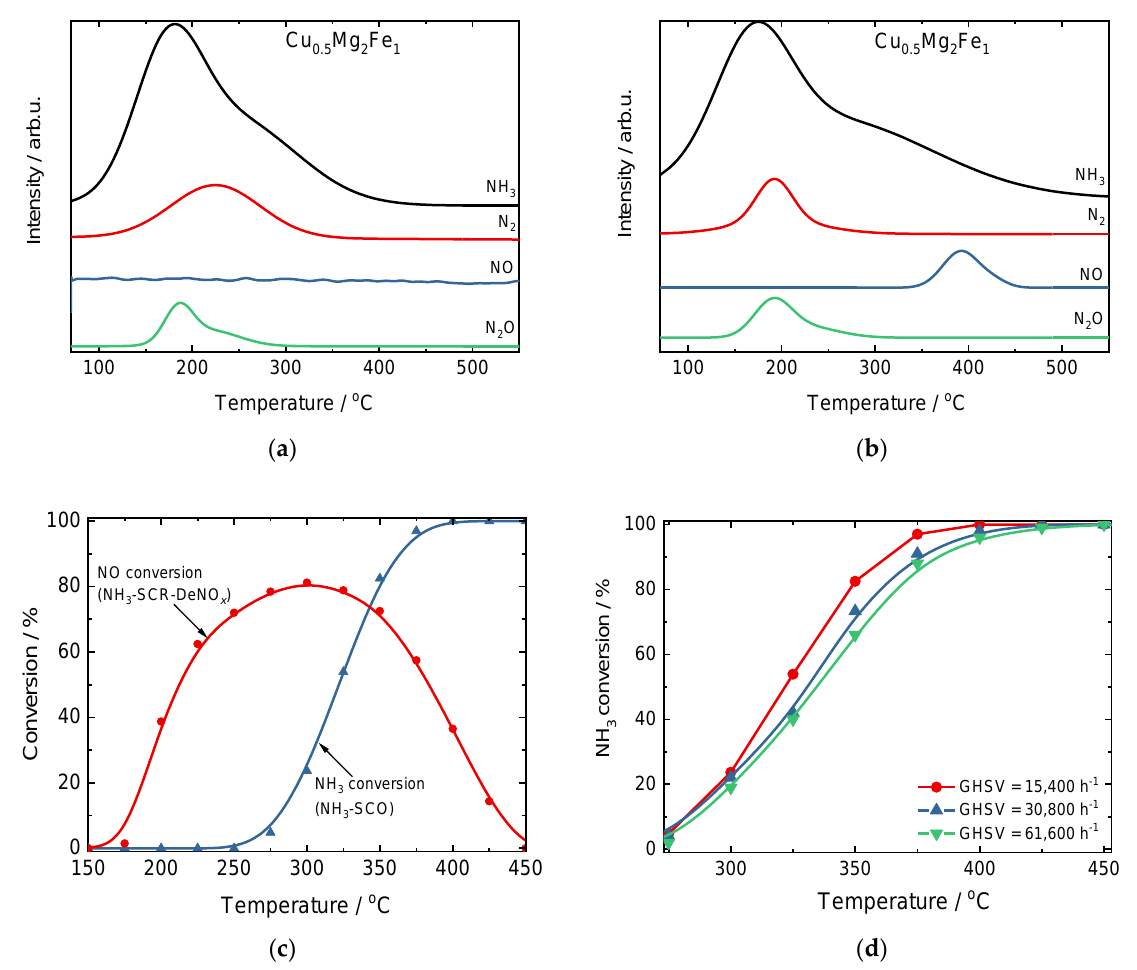
Figure 3. Results of temperature-programmed desorption of NH 3 in ( a ) pure He or ( b ) 5 vol.% O 2 /He, adsorption: 70 °C, 1 vol.% NH 3 /He, ( c ) comparison of conversion of NH 3 and NO, and ( d ) comparison of the space velocities (SV) over the CuFeAl hydrotalcite-derived mixed metal oxides. Reprinted from [31] with permission of Springer.